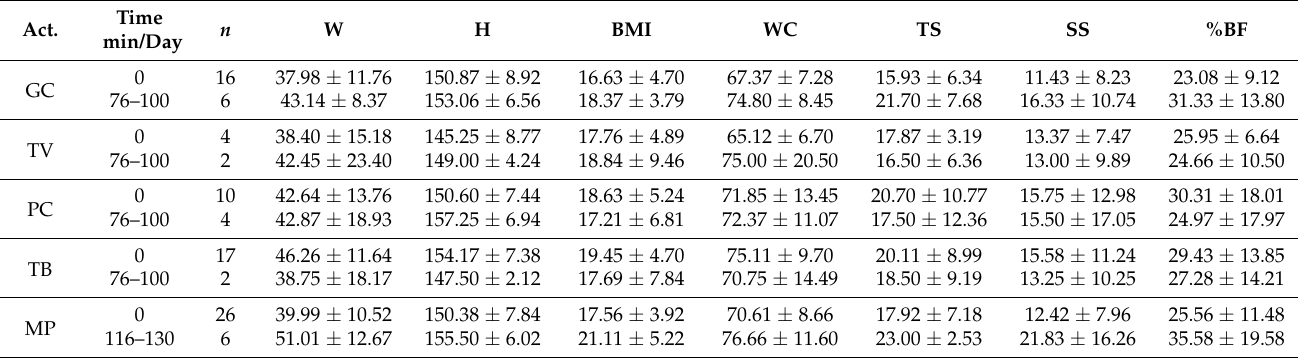
Table 8. Results of post-lockdown anthropometric variables in relation to daily time spent in activities related to screen exposure.